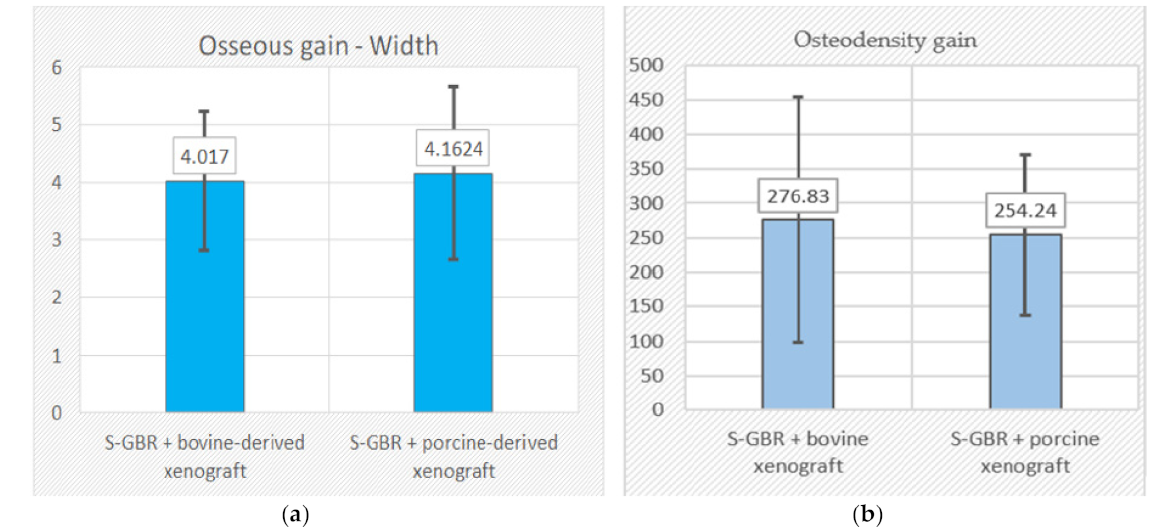
Figure 4. ( a , b ) Intergroup comparisons of bone gain (width, osteodensity) at 6 months follow-up. (S-GBR + bovine-derived xenograft group vs. S-GBR + porcine-derived xenograft group.).